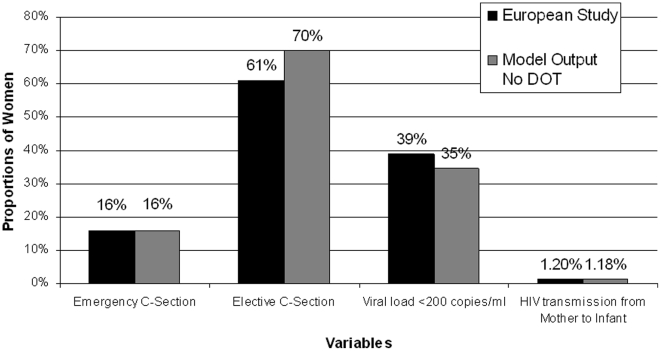
Model Calibrations.The model was calibrated to a 2005 European Collaborative Study that examined the effect of HAART on prevention of mother-to-child transmission in over 4000 mother-child pairs [33]. We calibrated the output of our model's self-administered therapy branch to the European study's results for proportion of women receiving an emergency C-section; proportion of women receiving an elective Cesarean section; proportion of women with an undetectable viral load (less than 200 copies/ml); and percent of HIV transmission to the infant.